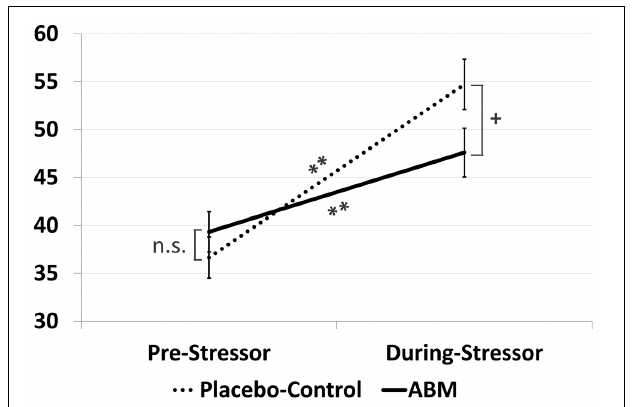
FIGURE 4 | Simple slope analyses: the estimated change in state anxiety from pre to during the stressor task, as a function of the interaction between baseline attention bias and training group (ABM/Placebo-control).